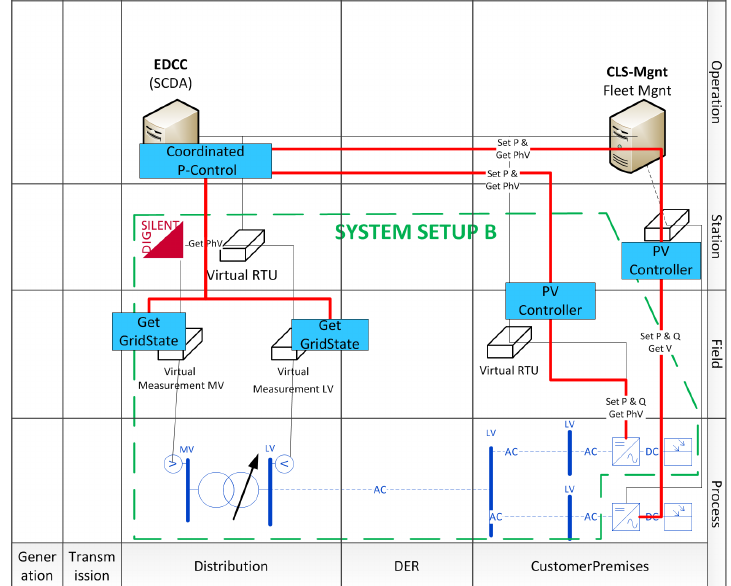
Figure 13. Combined SGAM-layer-diagram of the implemented case study. The base layer depicts the real and simulated components. The boundary of the PHIL setup is illustrated as a green dashed line. The utilised functions are depicted in blue boxes. This diagram uses the template provided by